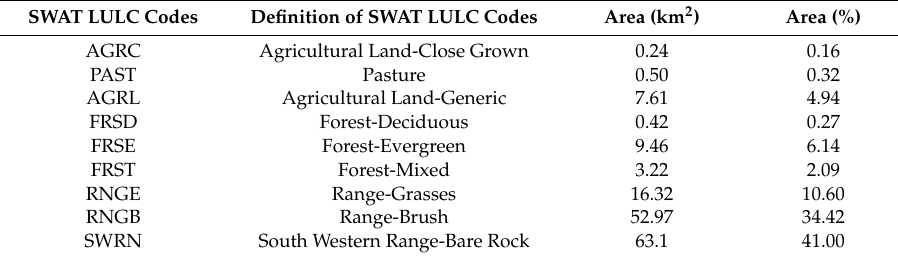
Table 1. Soil and water assessment tool (SWAT) codes and areas for